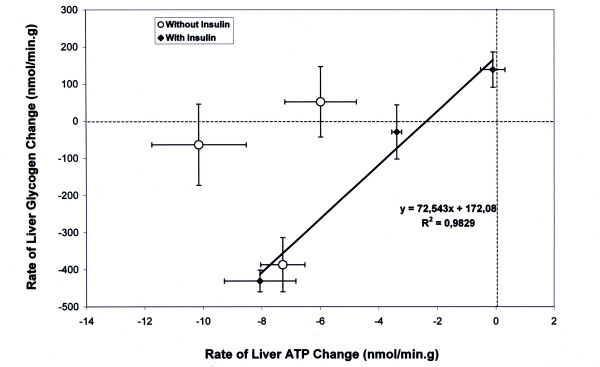
Correlation between the rates of ATP and glycogen changes in presence of insulin according to the perfusate glucose concentration. The rates are expressed in nmol·min-1·g-1. The equation for the linear correlation is fluxglycogen = 72.543(fluxATP) + 172.08, R2 = 0.98. To obtain a positive net flux of glycogen (net synthesis), the net ATP consumption must not exceed 2.4 nmol·min-1·g-1.